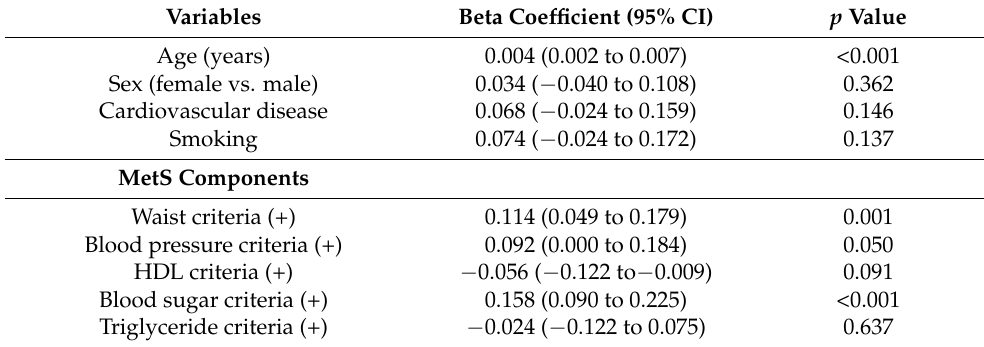
Table 3. Linear regression for